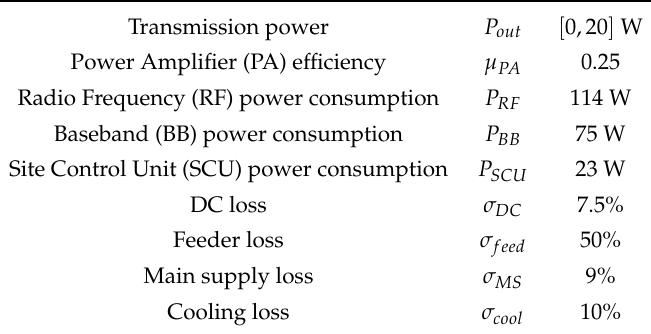
Table 2. TETRA base station power consumption parameters.